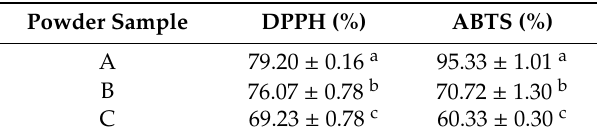
Table 3. Antioxidant activity of FOCE